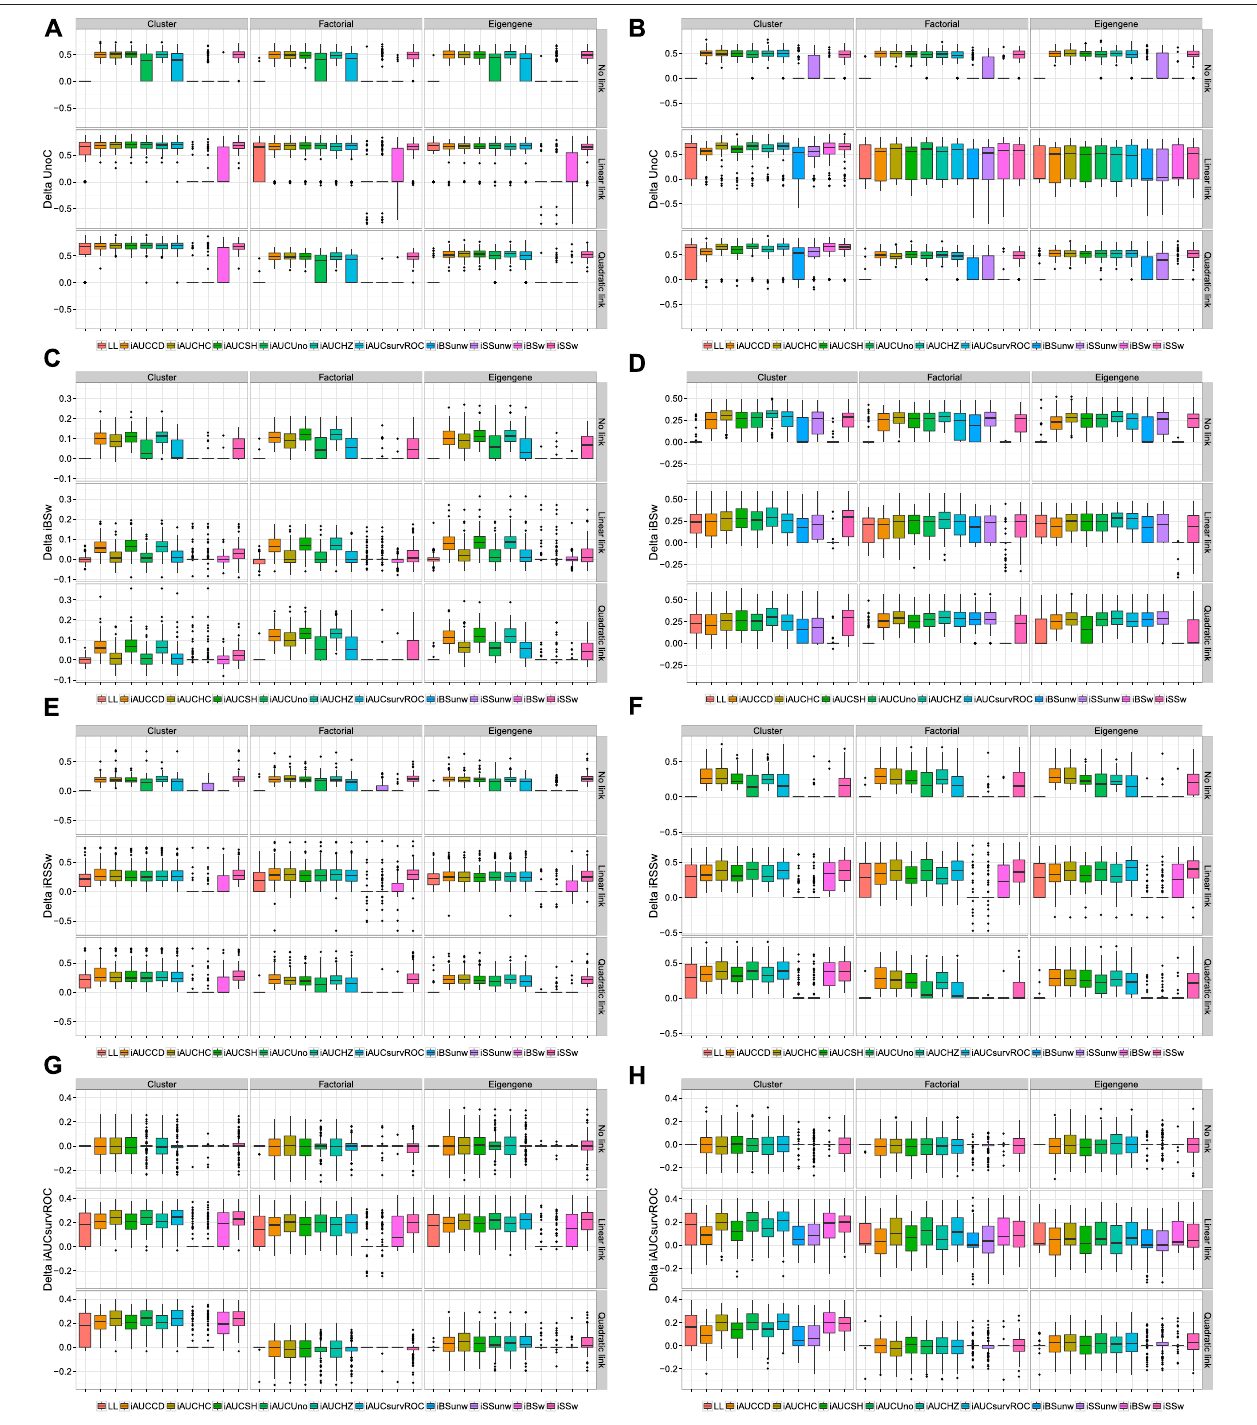
FIGURE3| Panelbyperformancemeasure(row)andmodels(columns)displayingthedeltasbetweentheperformanceachievedforanyCVcrit − theperformance achievedforvHCVLL. Top: Δ ofUnoC.panel (A) :PLS − Cox.panel (B) :sPLSDR. Row2: Δ ofiBSW.panel (C) :PLSDR. panel (D) :DKsPLSDR.Row3: Δ ofiRSSW. panel (E) : autoPLS − Cox. panel (F) : PLSDR. Bottom: Δ of iAUCSurvROC. panel (G) : PLSDR. panel (H) : sPLSDR.